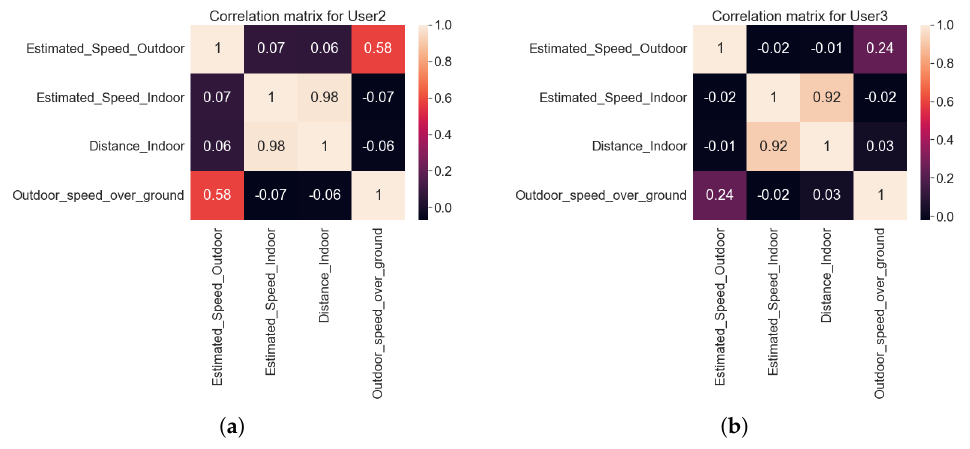
Figure 12. Correlation matrix. ( a ) User 2; ( b ) User 3.